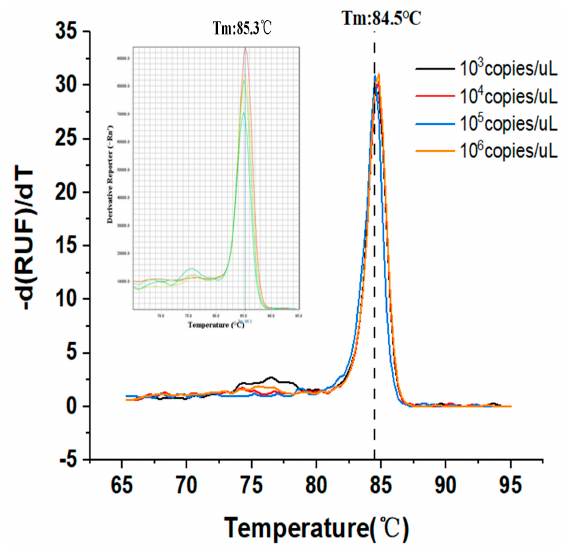
Figure 5. The melt curve analysis of the template with a concentration of 10 3 –10 ⁶ copies/µL obtained from the HDLRT-qPCR system as well as the real-time PCR amplification (ABI-STEPONE) system (shown in the upper left of the figure, the blue, green, yellow, and red lines correspond to concentrations of 10 3 –10 ⁶ copies/µL), showing the first derivative change in fluorescence intensity as a function of temperature. Meanwhile, only a single peak corresponding to the PCR product was observed. The amplicon is clean and specific.